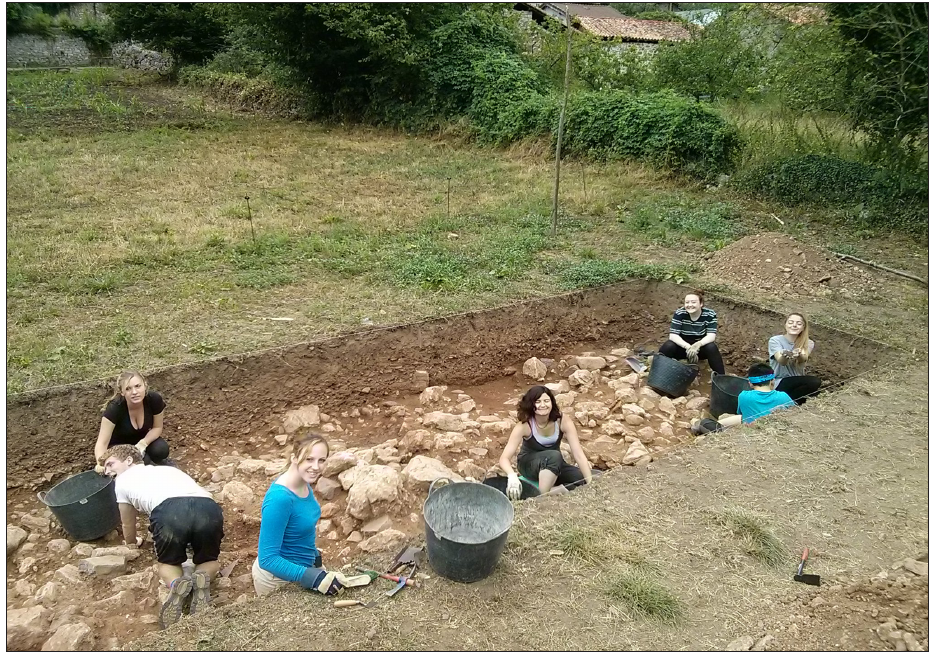
Figure 2: The excavation site showing the remains of buildings destroyed in the flash